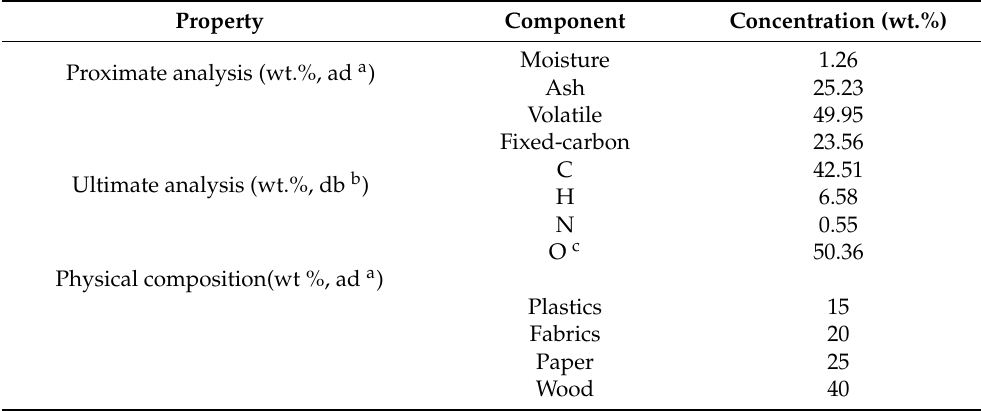
Table 1. Characteristics of the industrial organic solid